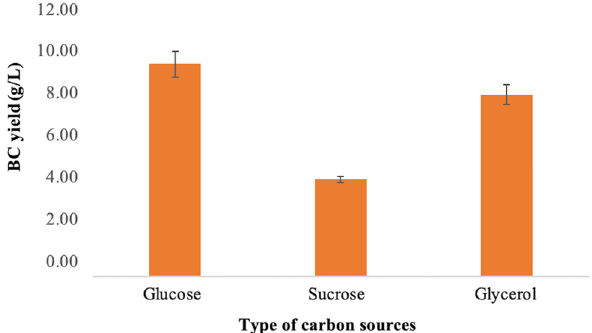
Figure 4: BC yield ( g/L ) produced by P. kudriavzevii USM - YBP2 sup - plemented with various carbon sources; glucose, sucrose, and gly - cerol at 30°C under static